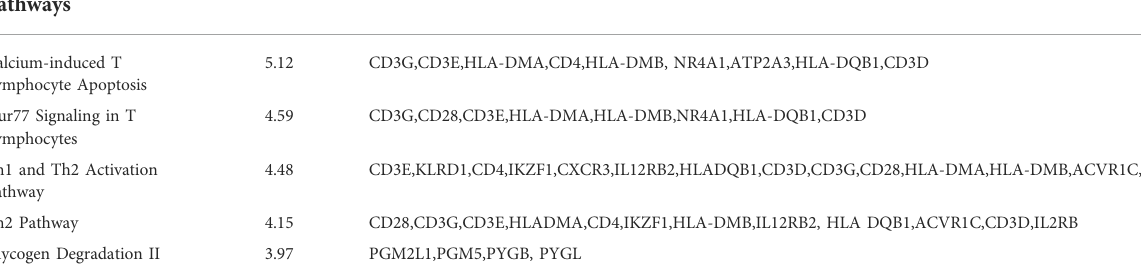
TABLE 3 Ingenuity Canonical Pathways enriched in Wt mice exposed to hyperoxia. Ingenuity canonical pathways